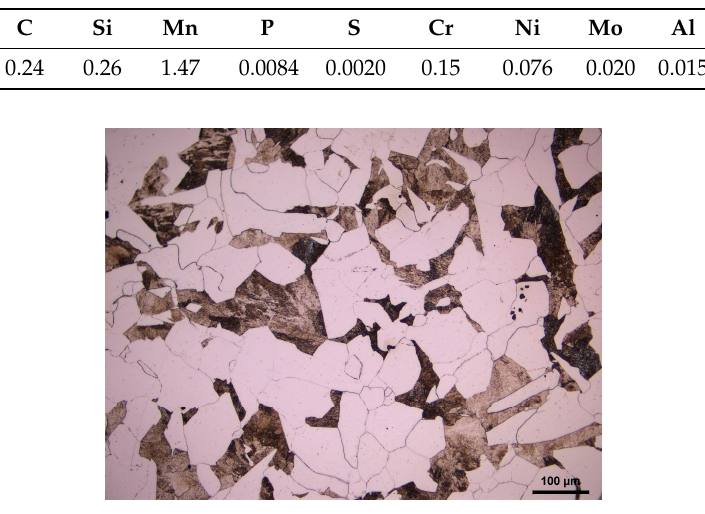
Figure 1. The initial as-cast microstructure of 20Mn5 steel.